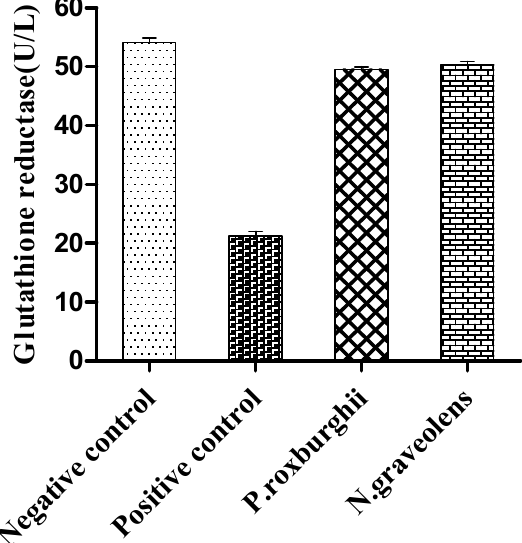
Figure 5. Serum glutathione reductase activity in different groups.